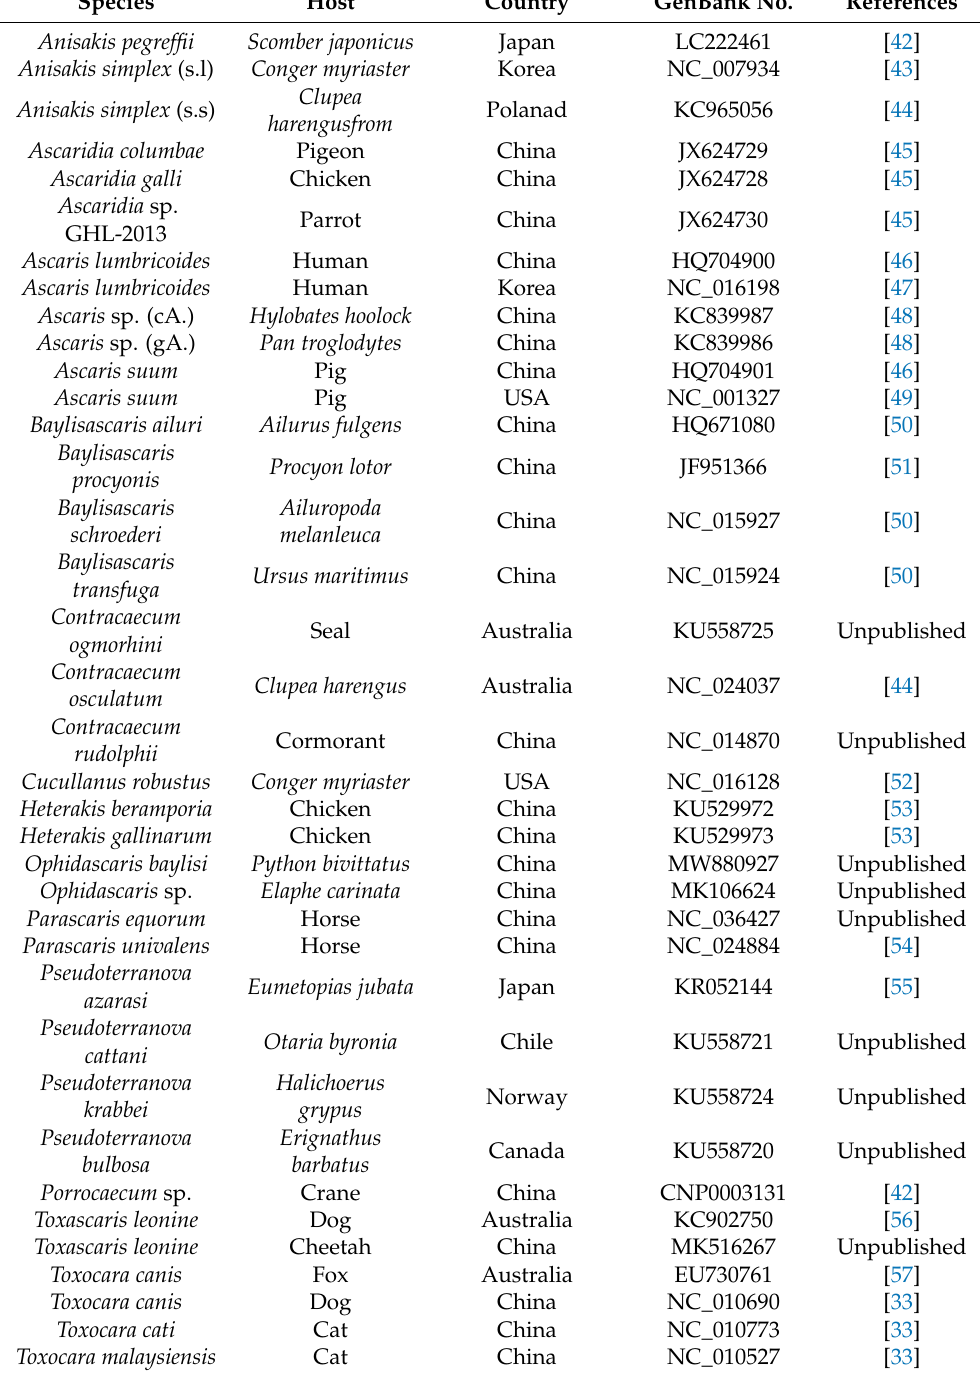
Table 1. Summary of the mitogenome information included in this